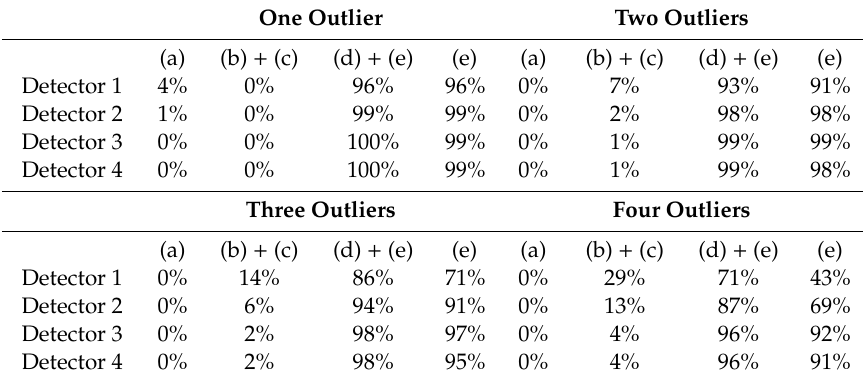
Table 5. The statistical results of four detectors in Case